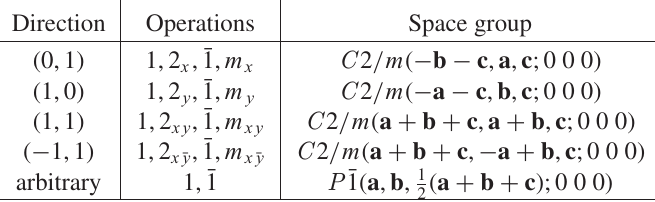
Table 3. Isotropy subgroups of the irrep E g of I 4 /mmm , depending on the direction of the order parameter within the irrep space. For each subgroup its conventional basis is indicated in terms of the basis ( a , b , c ) of I 4 /mmm . For completeness the null origin shift between the two unit cells is also listed. The conventional setting with the monoclinic unique axis along the b -direction is used. Direction Operations Space